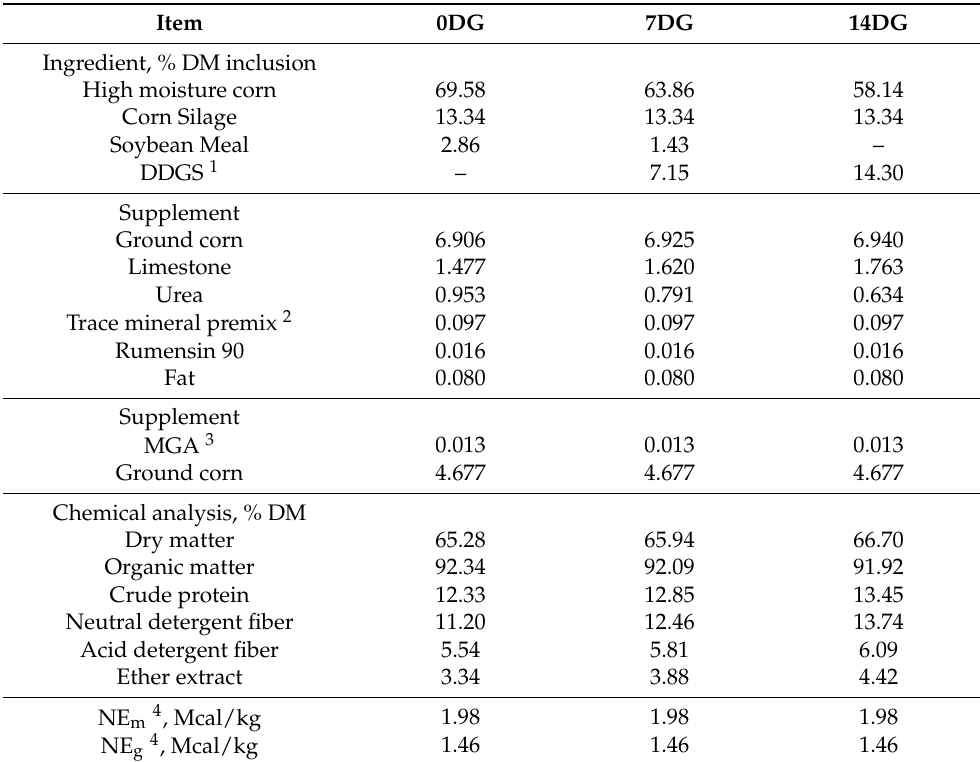
Table 1. Diet composition and nutritional